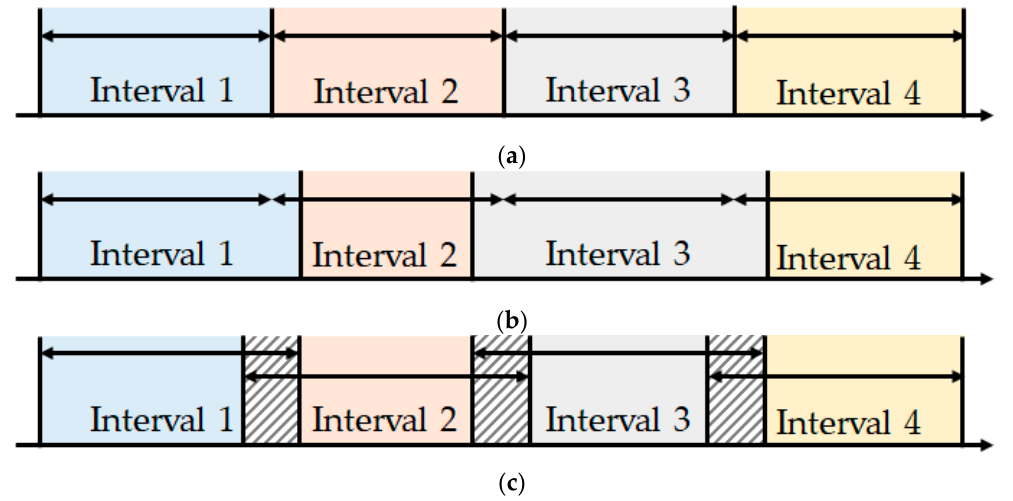
Figure 2. Conceptual diagram of interval division method: ( a ) Case 1; ( b ) Case 2; ( c ) Case 3.